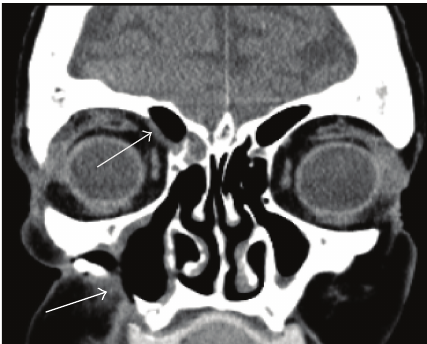
Figure 1: Coronal section CT image showing bony destruction in the lateral wall of the maxillary antrum with bone appearing to show some erosion and thickening. Bony dehiscence seen on the right superior orbital plate (white arrows) (courtesy of Dr. Tauseef Ashraf, Department of Radiology, Pilgrim Hospital, United Lincolnshire Hospitals NHS Trust).